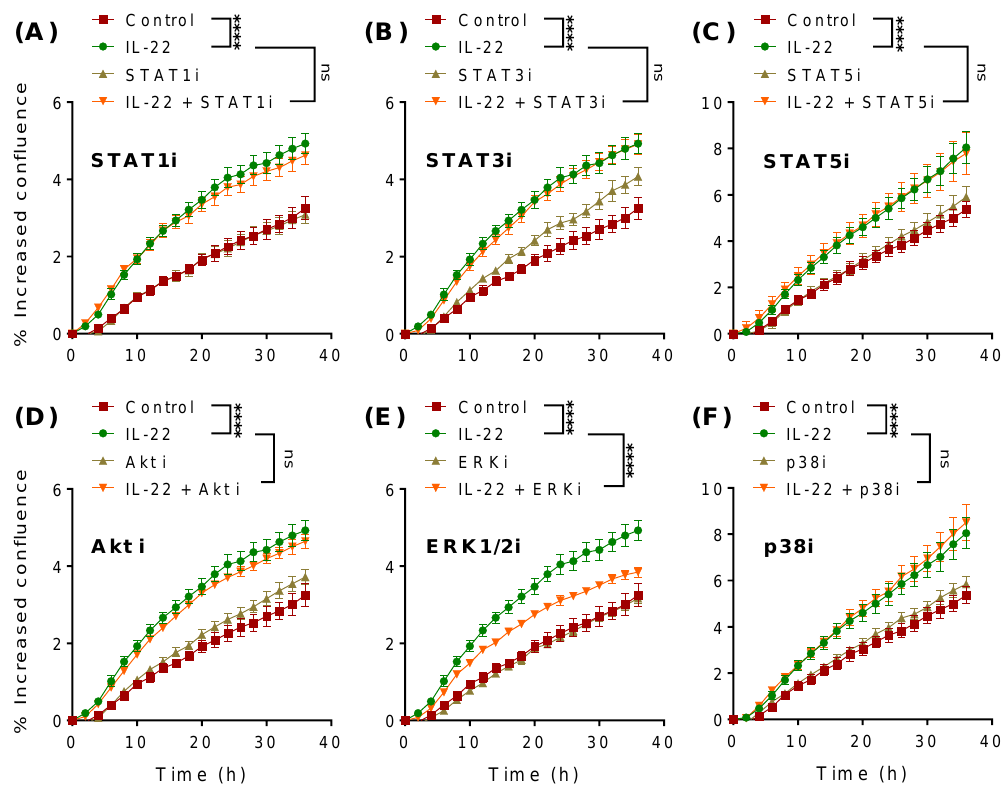
Figure 3. Signaling pathways involved in IL-22-mediated intestinal LS174T cell proliferation. Cells were pre-treated with inhibitors against ( A ) STAT1 (50 μM), ( B ) STAT3 (50 μM), ( C ) STAT5 (50 μM), ( D ) Akt (10 μM), ( E ) p38 (10 μM), or ( F ) ERK (10 μM) alone for 1 h and then observed in the absence